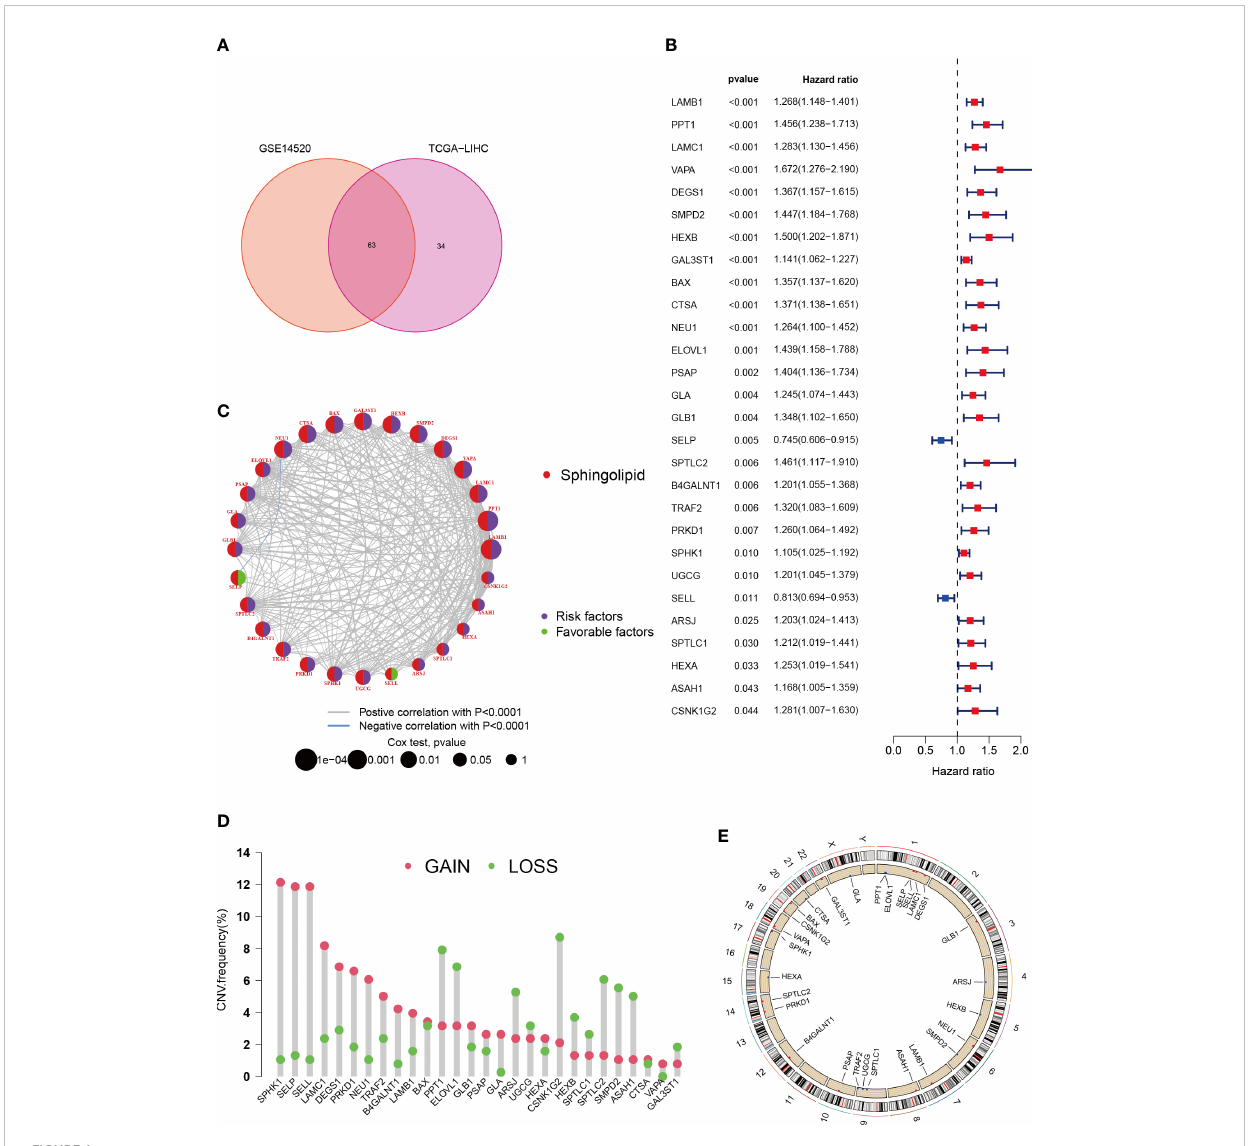
FIGURE 1 Characteristics and differences of sphingolipid-associated genes in HCC. (A) 63 sphingolipid-associated genes identi fi ed from TCGA-LIHC and GSE14520 cohort. (B) 28 SPGs ( P < 0.05) via the univariate Cox regression analysis. (C) Linkage between the 28 SPGs. (D) CNVs of 28 SPGs in TCGA- LIHC. (E) Chromosome site of